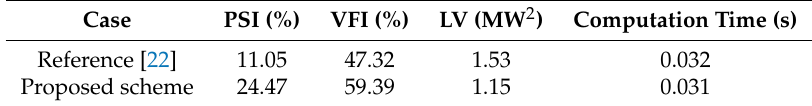
Table 10. Comparison